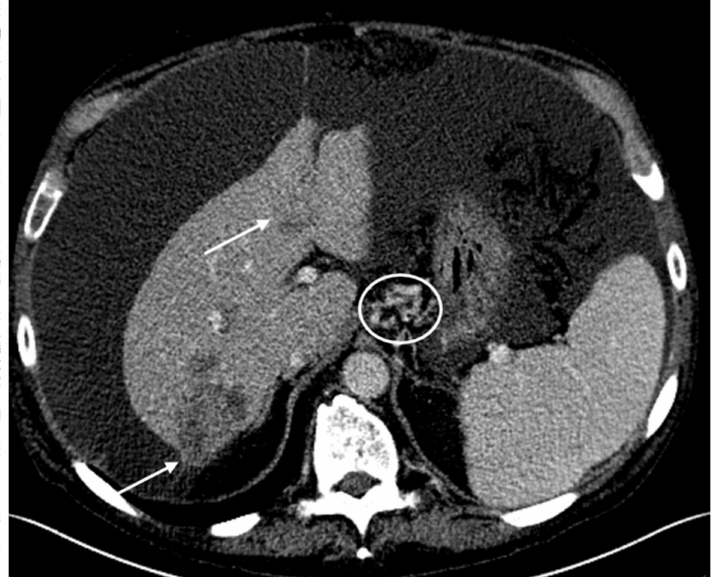
Figure 5. Following cycle 18 with CAPOX-B, there was evidence of tumor progression in the CT scans on the basis of the Response Evaluation Criteria in Solid Tumors (RECIST) guideline version 1.1. Axial contrast-enhanced CT scans demonstrate enlarging heterogeneous hepatic tumors (arrows). The larger right hepatic tumor now measures 6.3 cm with an exophytic component. There is a large-volume abdominal ascites that has progressively increased in size, with gastrohepatic varices